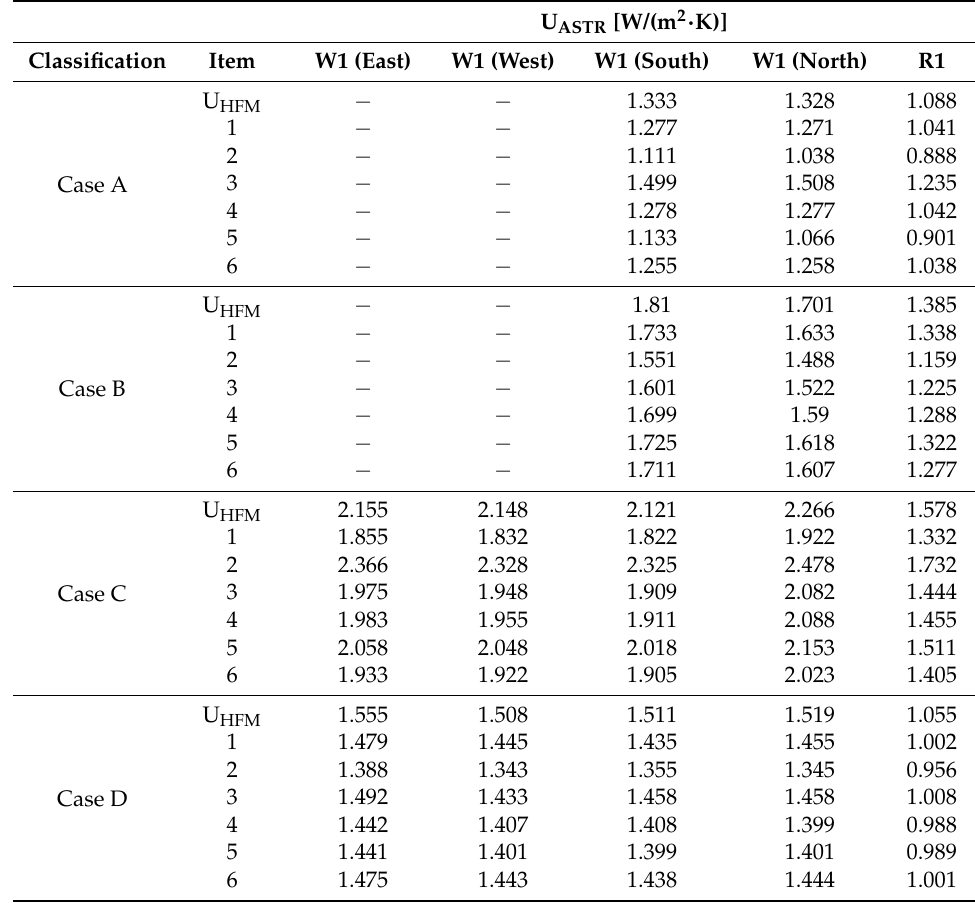
Table 8. Analysis of measurement results by data